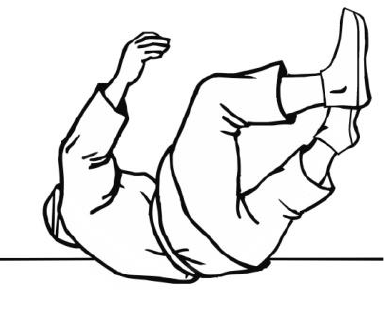
Figure 4. Moment of completion of the head acceleration reading.